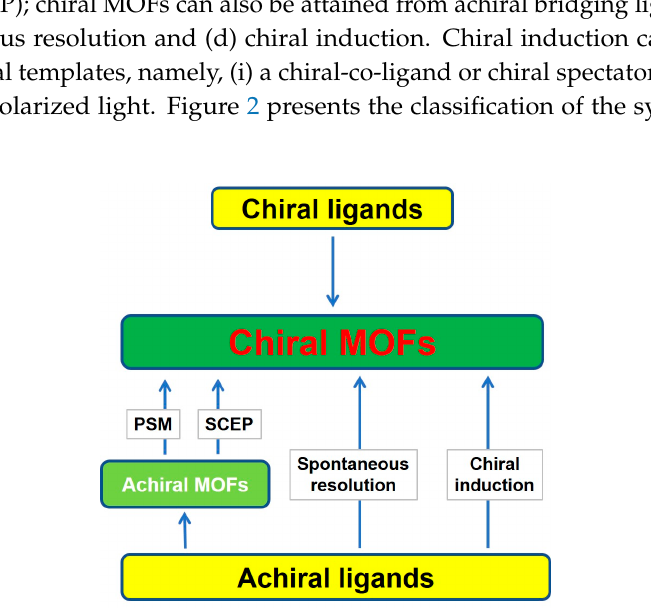
Figure 2. Schematic representation of the classification of the synthetic strategies of chiral MOFs. SCEP: superficial chiral etching process.